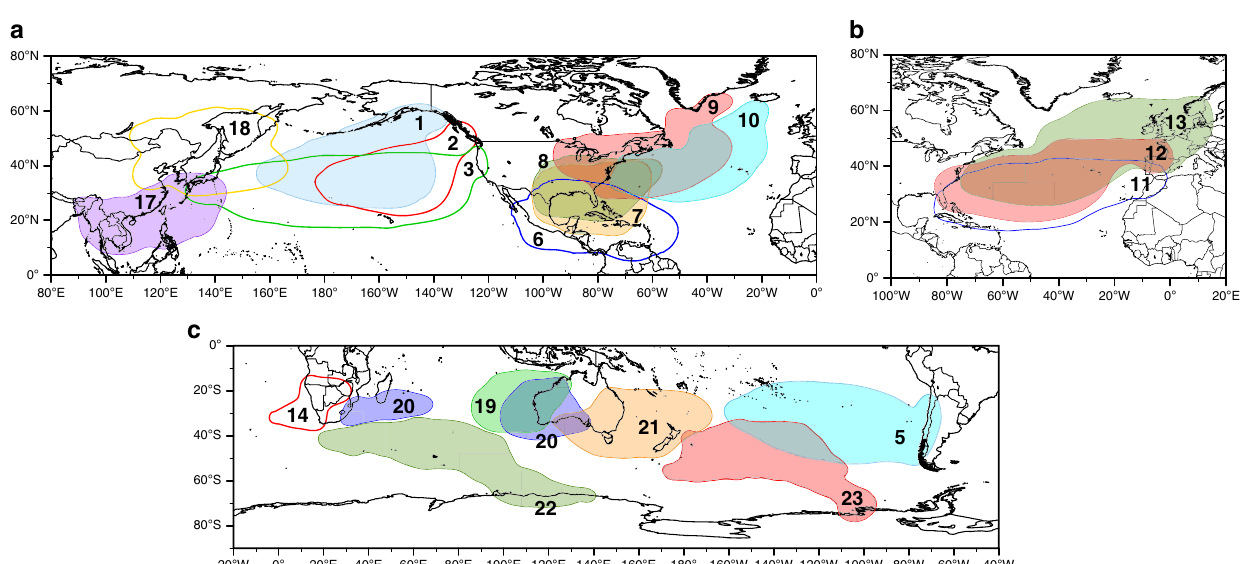
Fig. 2 Anomalous moisture uptake for regions of maximum occurrence of landfalling Atmospheric Rivers shown in Fig. 1. 90th percentile of the sum of anomalies of evaporation for each region identi fi ed in Fig. 1 ( a ) for north Paci fi c and North Atlantic Oceans, ( b ) for western Europe and ( c ) for the Southern Hemisphere. Filled areas show a signi fi cant increase in evaporation anomalies, while un fi lled areas show no signi fi cant trend (95% level of signi fi cance). The period of study is 1980 – 2017. Trends were calculated using Mann-Kendall test.